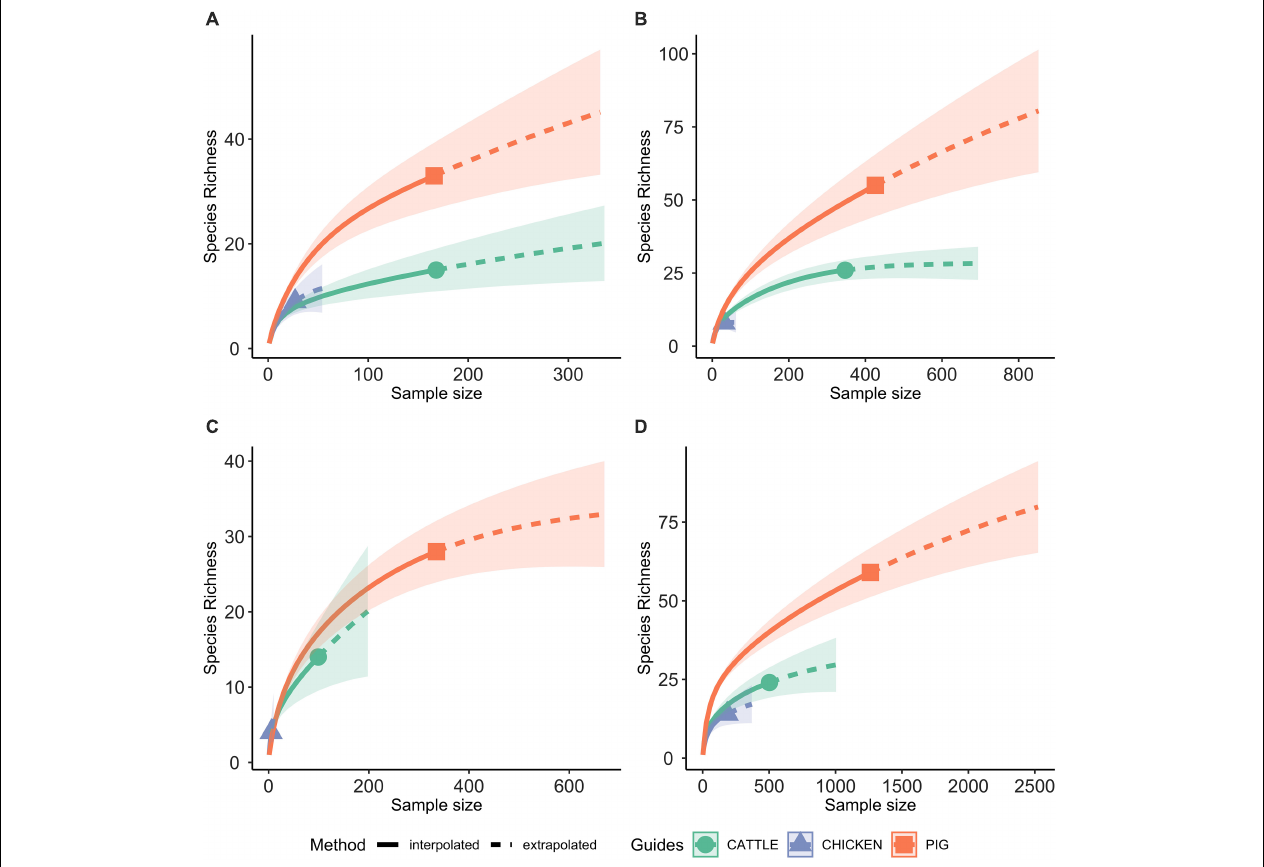
FIGURE 3 | Rarefaction curves, with 95% confidence intervals, of the number of phenotypic AMR profiles for each host species (species richness). Extrapolation to two times the sample size for each host species. (A) 2003 only; (B) 2004–2006 only; (C) 2007 only; (D) 2008–2014 only.